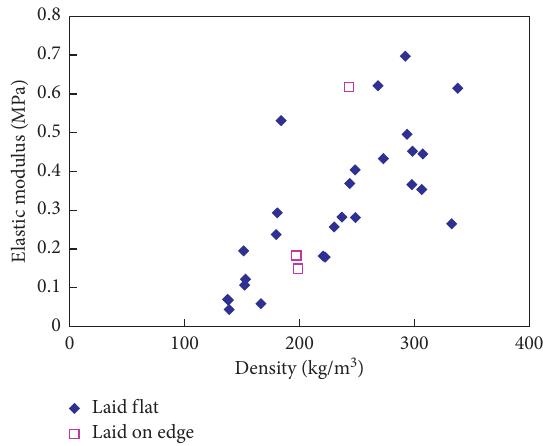
Figure 11: The relationship between the elastic modulus and density of unplastered straw